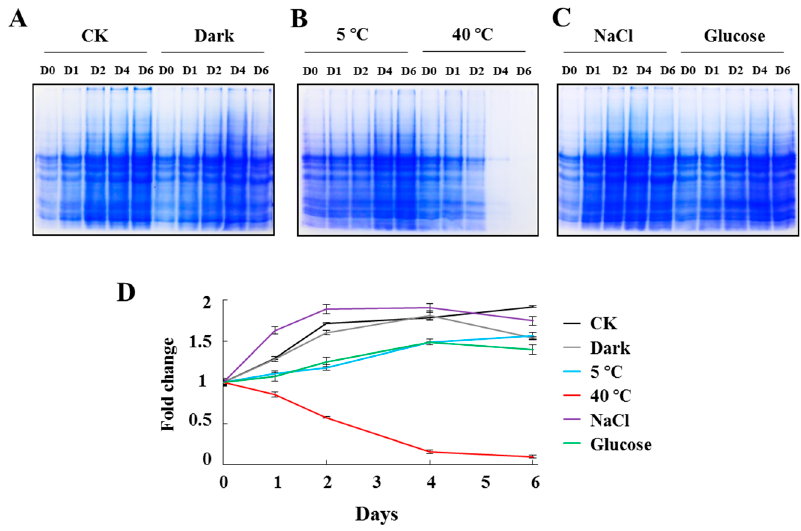
Figure 2. Total protein contents of Chlamydomonas reinhardtii cells cultured under various abiotic stresses. C. reinhardtii cells were collected by centrifugation at indicated time points, and total proteins were extracted and separated by sodium dodecyl sulfate polyacrylamide gel electrophoresis (SDS-PAGE). ( A – C ). Coomassie Brilliant Blue-stained gels. ( D ). Signals extracted from A–C by Lane 1D software. To normalize data collected from different gels, value at day 0 was set to one and fold changes at other time points were calculated. Data are average values from three independent experiments. Cells were grown without stress (CK, control) or in the dark, cold (5 ◦ C), heat (40 ◦ C), or with NaCl or glucose supplementation. Samples were collected on days 0, 1, 2, 4, and 6 of